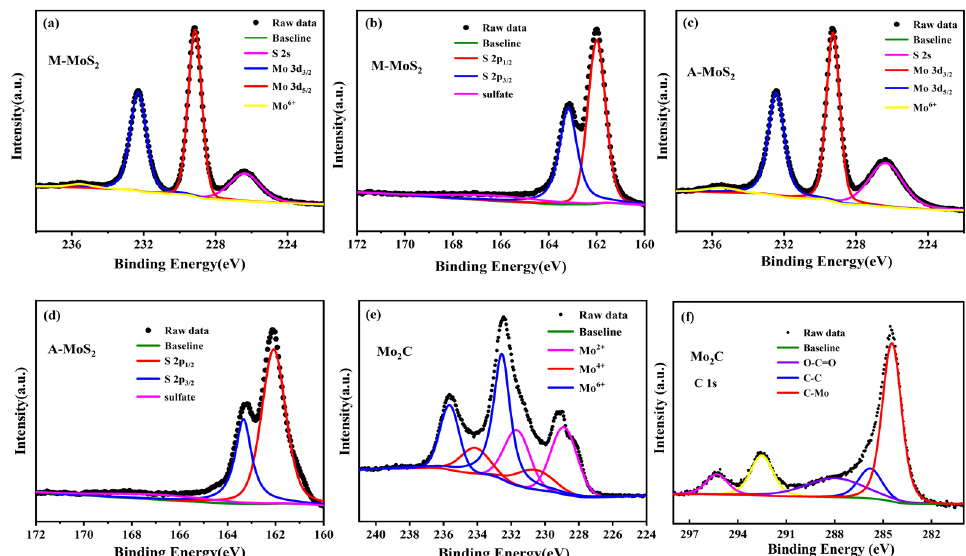
Figure 4. High-resolution XPS spectra of the Mo 3d ( a , c ), S 2p ( b , d ) regions of O-MoS 2 and W-MoS 2 respectively, and the Mo 3d ( e ), C 1s ( f ) regions of Mo 2 C.